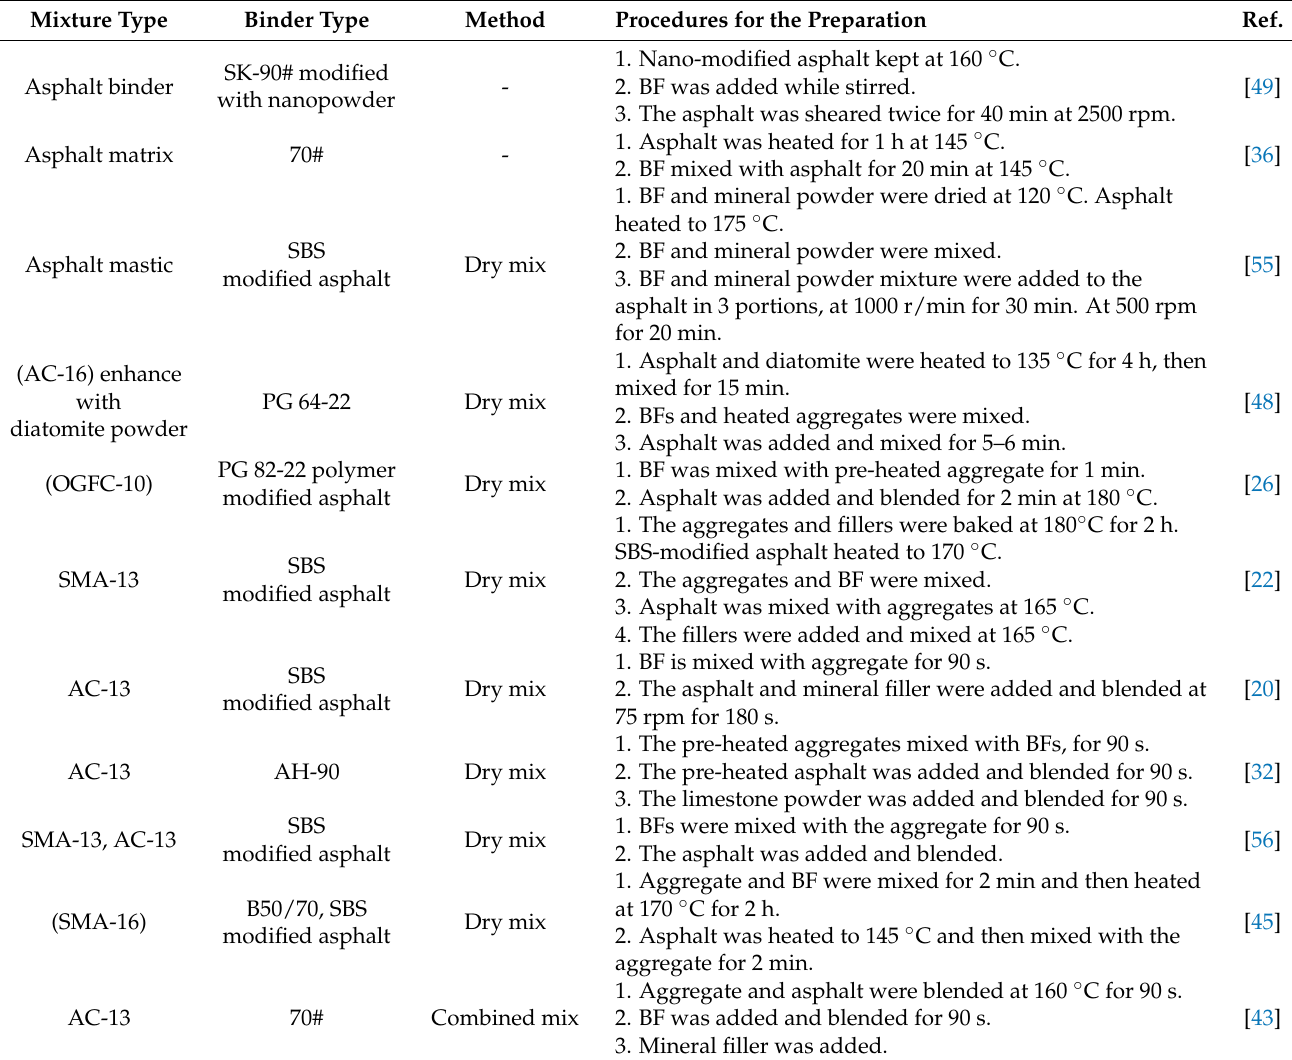
Table 2. The preparation process of the basalt fiber asphalt